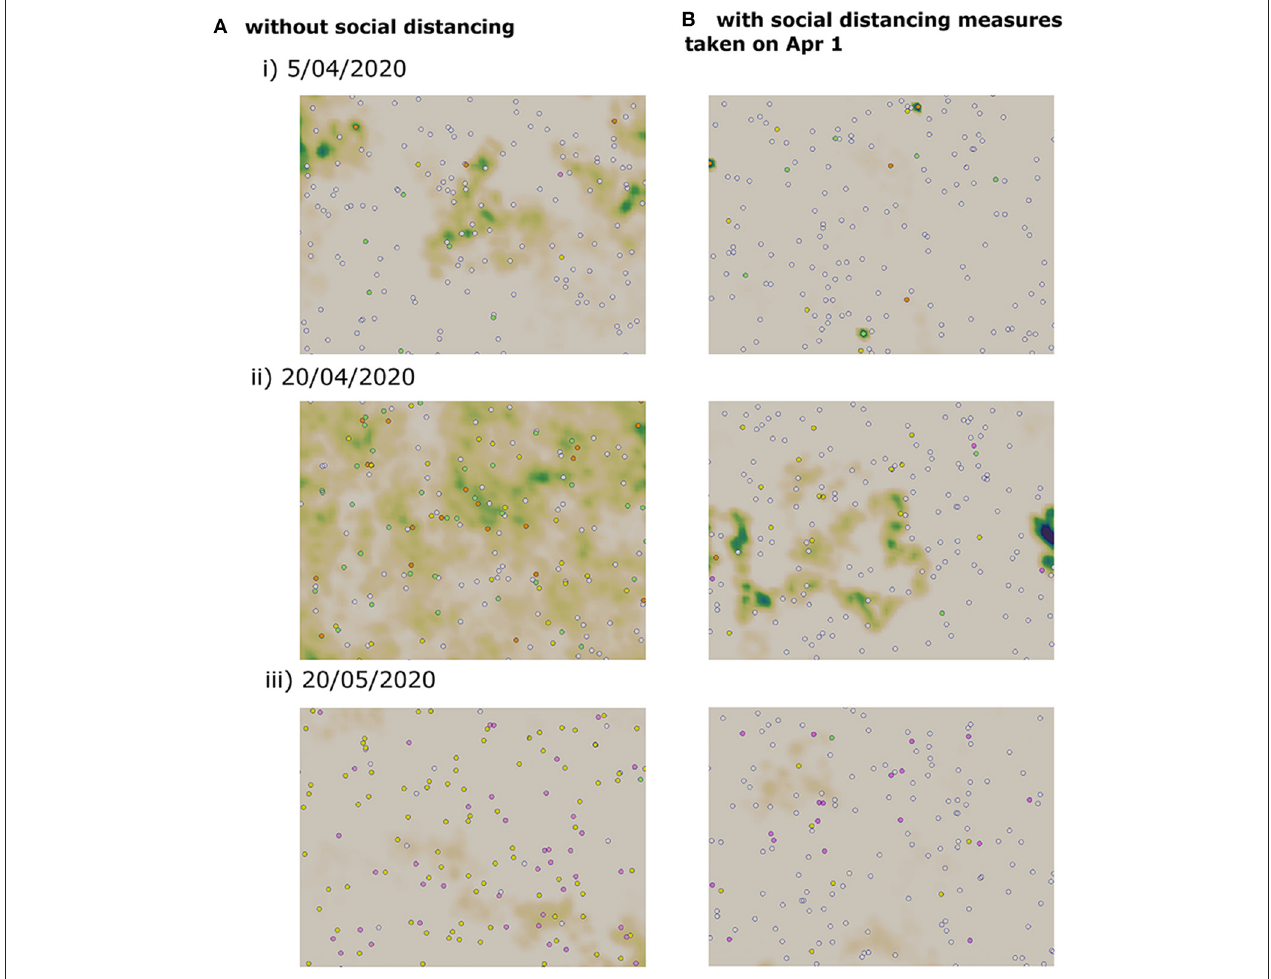
FIGURE 5 | Snapshots of numerical simulations showing the effect of social distancing on the transmission dynamics of COVID-19 in three different dates. (A) Without social distancing measures. (B) With a partial lockdown which targets 75% of the